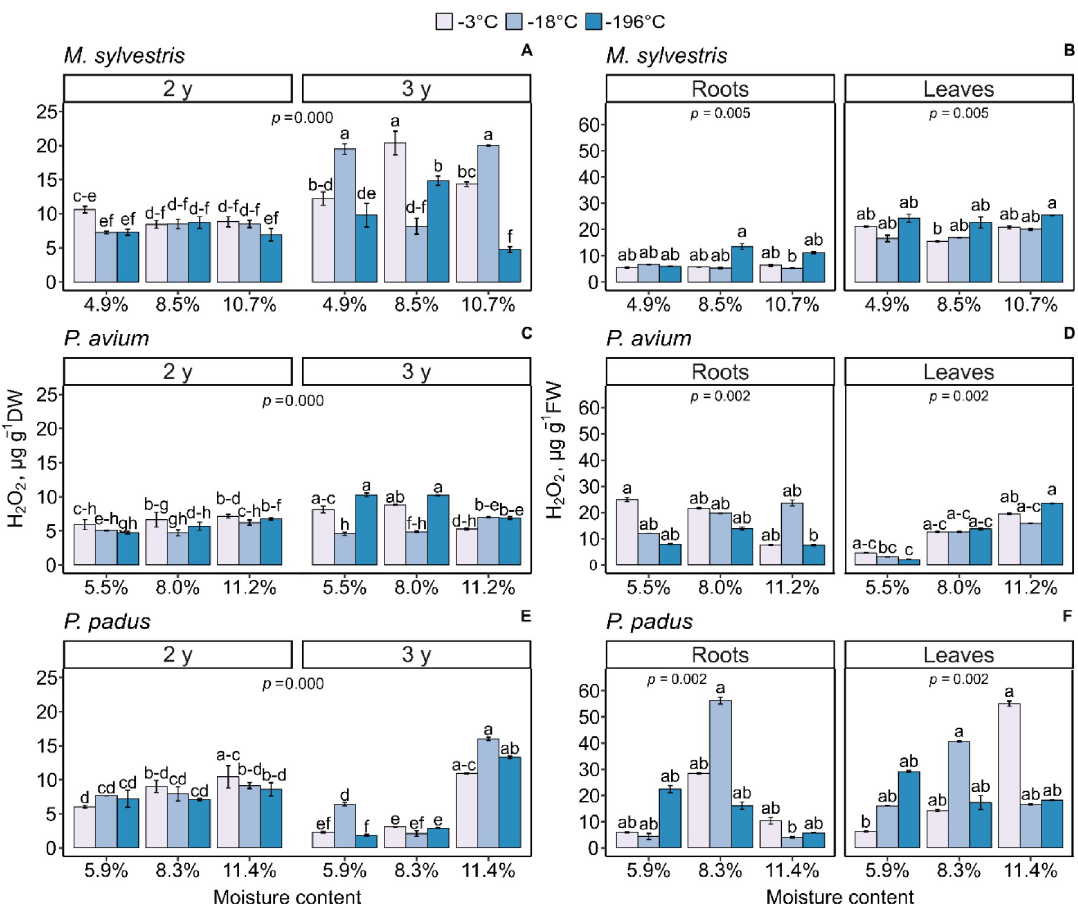
Fig 1. Changes in the levels of hydrogen peroxide (H 2 O 2 ) reported in germianted seeds (A, C, E) and 3-month-old seedlings derived from the seeds (B, D, F) of M . sylvestris (A, B), P . avium (C, D) and P . padus (E, F). In germinated seeds, the level of H 2 O 2 interaction between MC x storage temperature x storage time was compared. In 3-month seedlings, the level of H 2 O 2 was measured in leaves and roots. Data are the means ± standard error obtained from three independent experiments with similar results. Statistically significant differences are indicated with different letters among the groups, followed by Tukey’s test for germinated seeds and Dunn’s test for seedlings at p � 0.05. the 3 rd year of storage when the level of H O decreased in germinated seeds with 5.9% and 2 2 8.3% MC. In germinated seeds kept with 11.4% MC, the level of H O increased and was 2 2 clearly dependent on storage temperature. Both the roots and leaves of P . padus 3-month-old seedlings contained up to 20 times higher H O concentrations than the seeds from which 2 2 they were derived (Fig 1F). In both the roots and leaves of P . padus seedlings, extremely high levels of H O were detected in seeds with 8.3% MC at -18˚C. Inleaves, similarly high H O 2 2 2 2 levels were also reported in the 11.4% MC and -3˚C treatment.